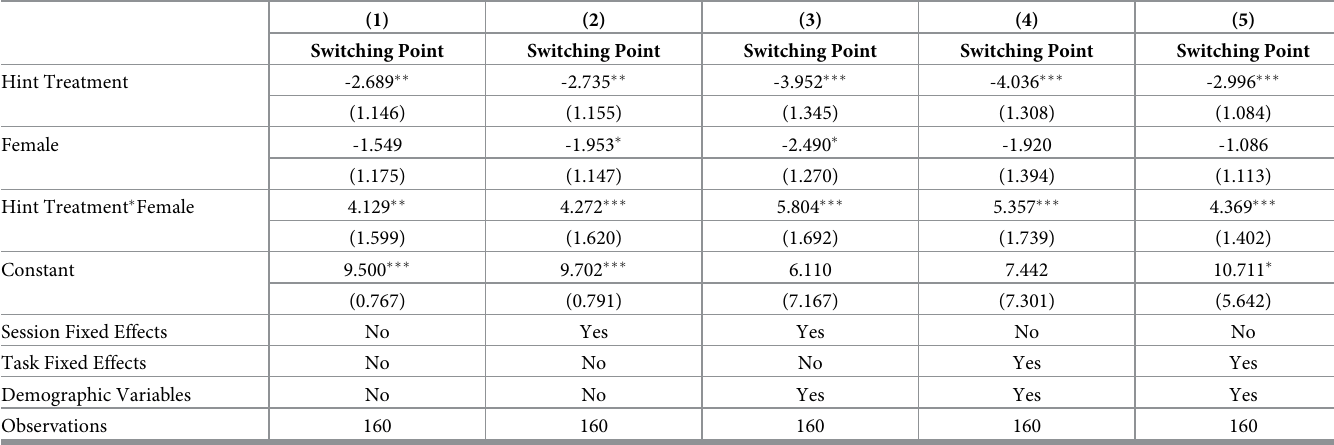
Table 5. Difference-in-difference estimates of gender gaps in switching